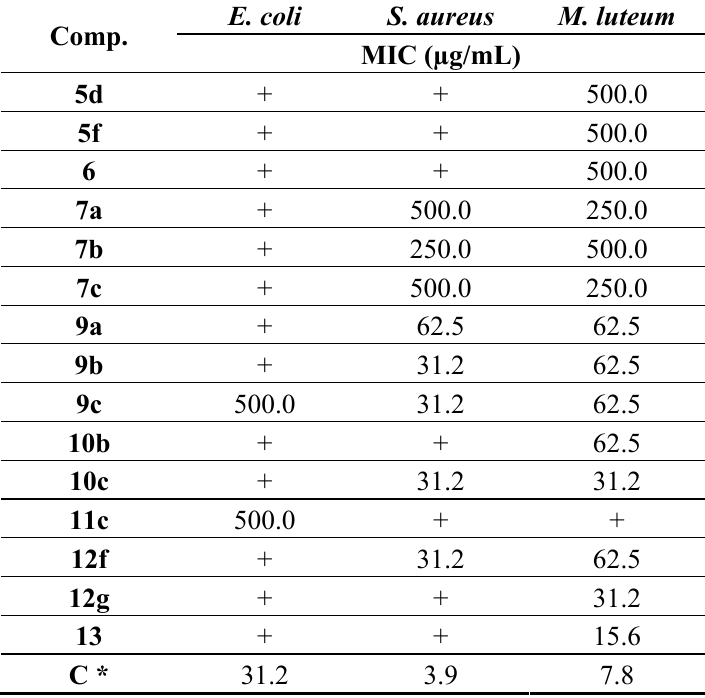
Table 2. Bactericidal activity of the synthesized compounds determined by serial dilution method (only compounds that gave positive results at least in one case are included in the table).